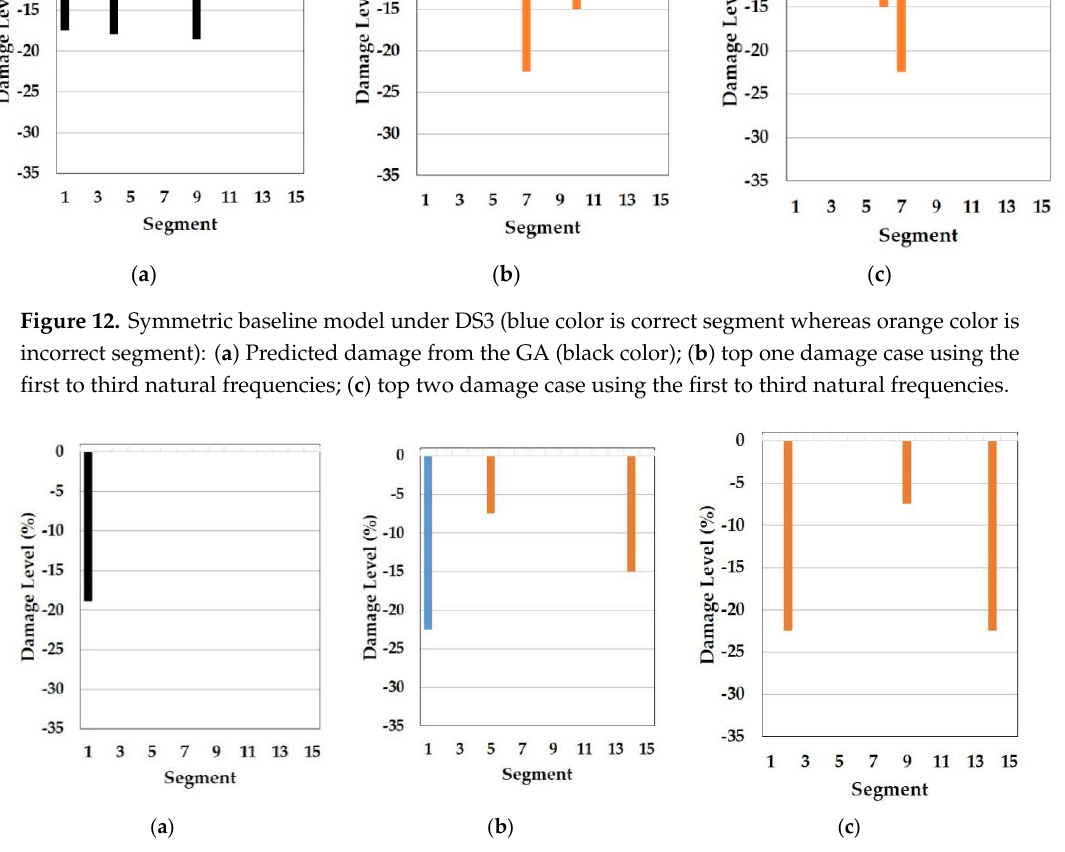
( a ) ( b ) ( c ) Figure 14. Independent baseline model under DS3 (blue color is correct segment whereas orange color is incorrect segment): ( a ) Predicted damage from the GA (black color); ( b ) top one damage case using the first to fourth natural frequencies; ( c ) top two damage case the first to fourth natural frequencies. 4. Conclusions Aiming at contributing to a more applicable real-time SHM offshore, this research proposed a multiple damage detection method using cosine similarity of the rate of change of natural frequencies. To sum up, the process is comprised of three parts: Damage individualization, damage recognition, and damage identification. A damage estimation matrix is constructed from a preliminarily updated FE model using DOE and modal analysis in the first stage. In the recognition process, the rate of change of natural frequencies from OMA based on sensor data during operating is normalized and utilized as a normalized warning index. When the index becomes larger than a threshold, it is judged that damage happens, and subsequently, the damage reflection vector is generated in this state.